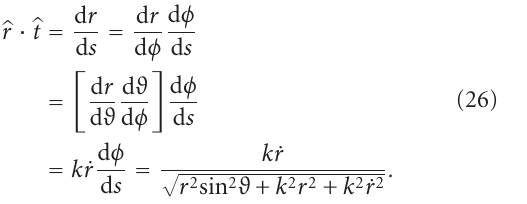
wherein ˙ r = d r/ d ϑ and, being in such a case ξ equal to the polar angle ϑ ,